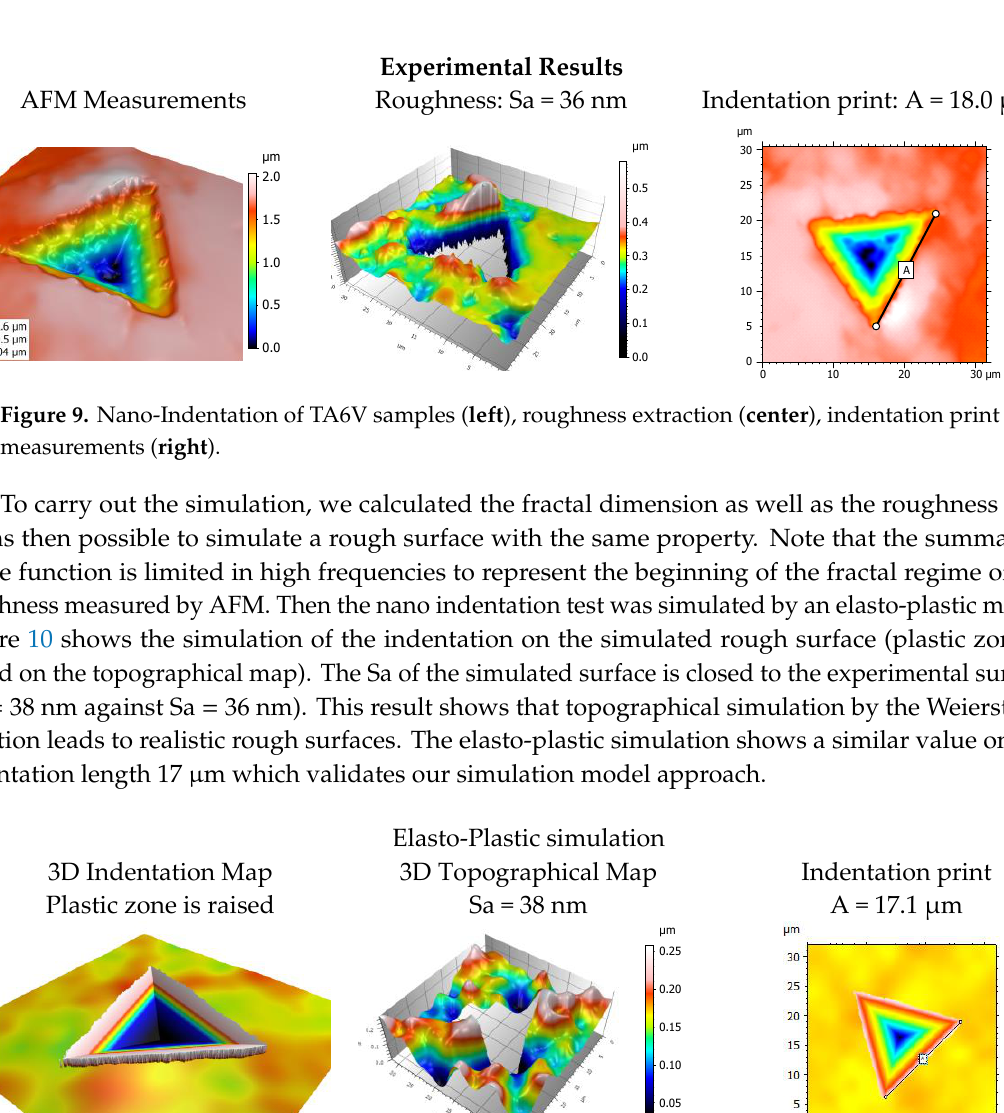
Figure 11. Frontier elastic/plastic deformations from elasto-plastic simulation of TA6V material ( left ). Probability density function of maximal roughness amplitude at plastification obtained from both simulated and experimental nano-indentations ( center ). Probability density function of surface integrity ( right ). 100% of integrity means that pass over a maximal peak amplitude of 0.43 µm, no plastification will occur). 5. Conclusions In this paper, we proposed and exposed the principle of a statistical workflow to be applied to the analysis of rough surfaces in order to predict the statistics of contact pressure from roughness analysis. By means of the proposed functions, a statistical protocol allows us to extract the density of probability of the maximal pressure of a rough surface. This estimate is based upon a classical hypothesis of local elastic response of roughness peaks. The detailed validation of the proposed methodology could either involve contact pressure experimental measurements or numerical simulations taking into account the elastic interactions between peaks in future developments. The probability density of local contact pressure is described well by a GLD density function. Then, it is possible to determine the probability that the pressure of contact generates a plastic deformation from